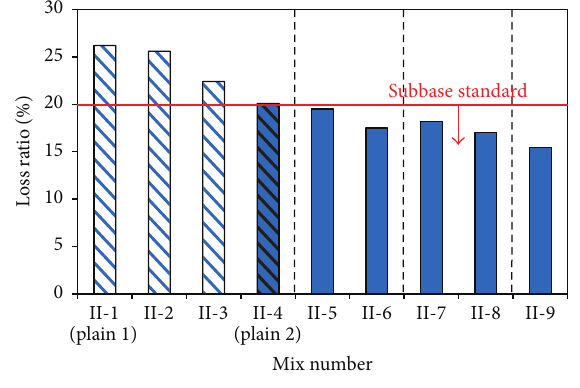
Figure 10: Abrasion